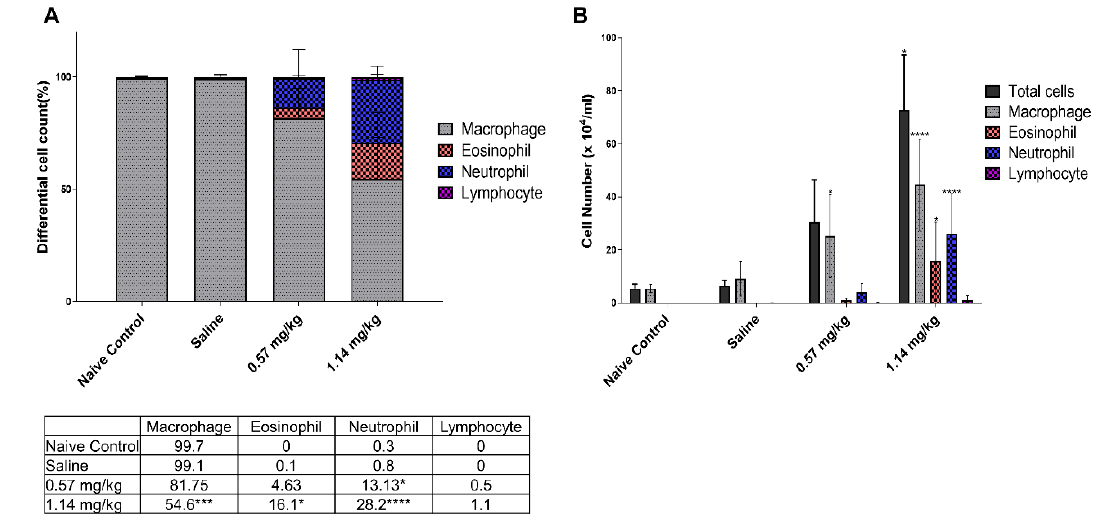
Figure 3. Effect of Kathon-induced changes on total and differential cell counts in the bronchoalveolar lavage fluid (BALF) of mice. Cell population composition as a percentage of total cells ( A ) and the number of total cells, macrophages, neutrophils, and lymphocytes ( B ) in the BALF of normal control (NC), saline, and Kathon mice. Data are presented as the mean ± standard deviation ( n = 5 per group). * p < 0.05, *** p < 0.001, and **** p < 0.0001 vs. saline.